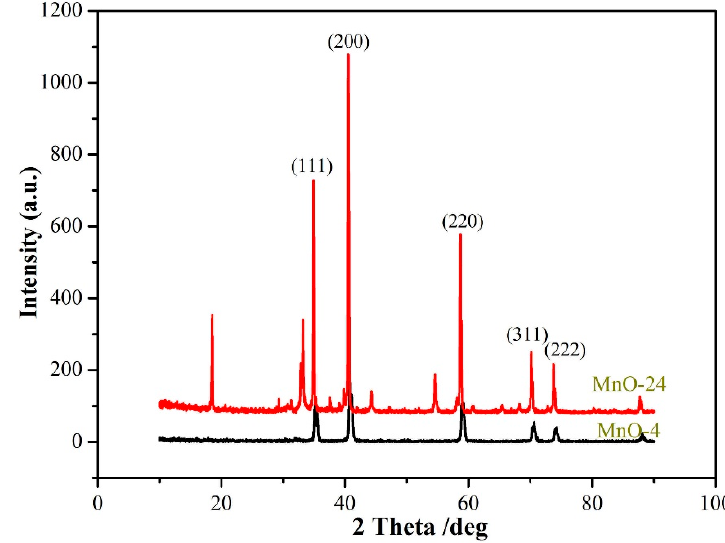
Figure 1. XRD patterns of the as-prepared MnO nanomixtures samples.